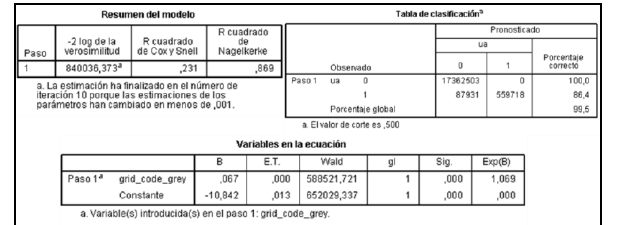
Figure 5. Natural breaks of night lights intensity (>= 164)